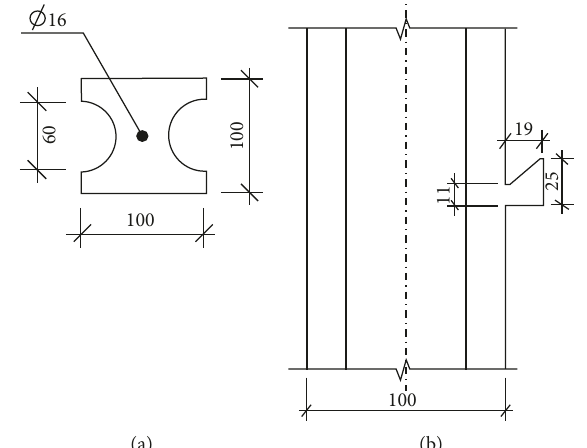
Figure 5: Sketch of prefabricated hanger column. (a) The dimension of prefabricated hanger column. (b) The dimension of hanger on prefabricated hanger column. Unit: mm.